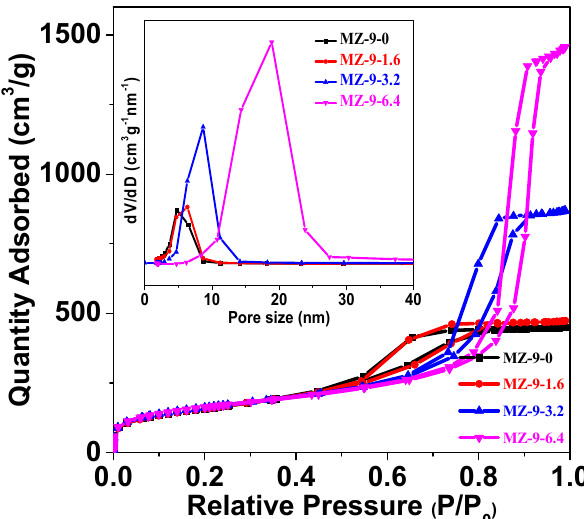
Figure 8. N 2 adsorption–desorption isotherms and BJH pore size distributions of MZ-9-0, MZ-9-1.6, MZ-9-3.2, and MZ-9-6.4.